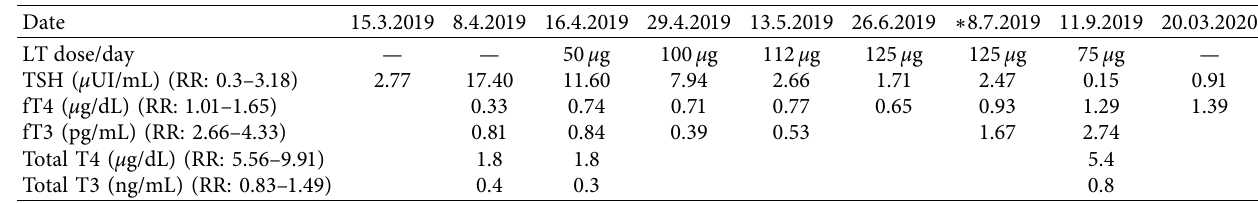
Figure 1: Evolution of proteinuria levels on urinalysis since nephrotic syndrome diagnosis until bilateral Table 1: Description of evolution of thyroid function tests over time under different doses of LT, before and after nephrectomy.